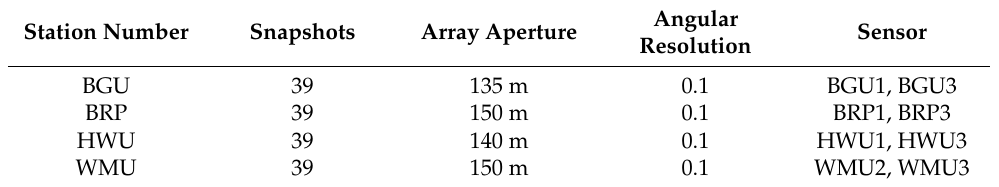
Figure 7. Time domain signal after 1-5 Hz filtering for four stations: ( a ) the total signal duration of the BGU station is 20 s; ( b ) the total signal duration of the BRP station is 30 s; ( c ) the total signal duration of the HWU station is 100 s; and ( d ) the total signal duration of the WMU station is 15 s. Table 2. Infrasound signal and the SBL algorithm parameter setting.